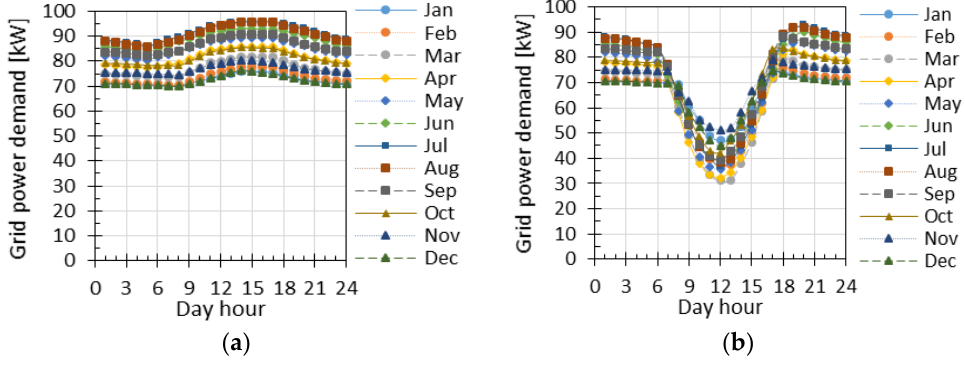
Figure 5. ( a ) Electricity demand structure and ( b ) refrigeration load structure of the reference